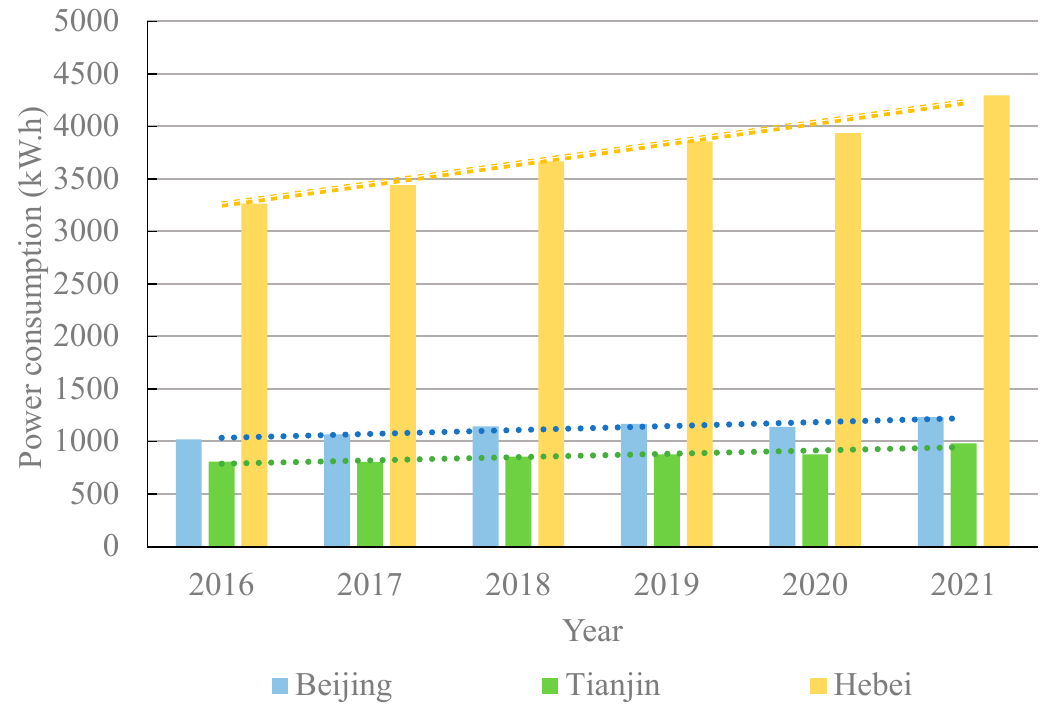
mechanism [42]. The operation of the new power market mechanism can effectively alle- viate the pressure on emission reduction but, at the same time, it can inhibit the activity of the carbon market [39] and reversely promotes the reform of the carbon market mech- anism. Figure 2. Power consumption in the Beijing–Tianjin–Hebei region from 2016 to 2021.